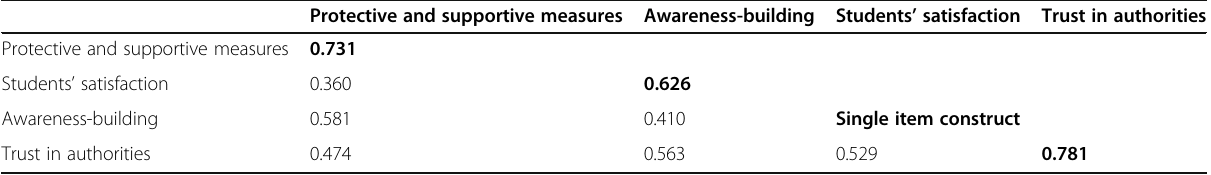
Table 4 PLS-SEM Fornell – Larcker test for discriminant validity Protective and supportive measures Awareness-building Students ’ satisfaction Trust in authorities Protective and supportive measures